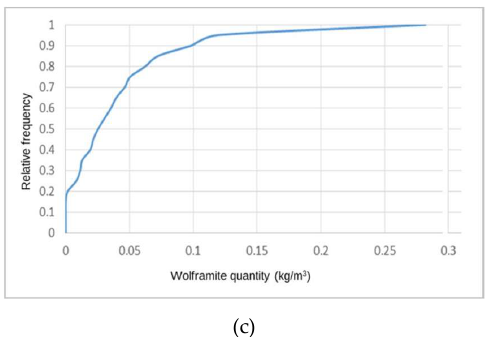
Figure 13. Step 4 Monte Carlo procedure for building composite histograms: ( a ) CL1 cumulative histogram; ( b ) CL2 cumulative histogram; and ( c ) composite cumulative histogram (Prob {CL1} = 0.9159 and Prob {CL2} = 0.0841).